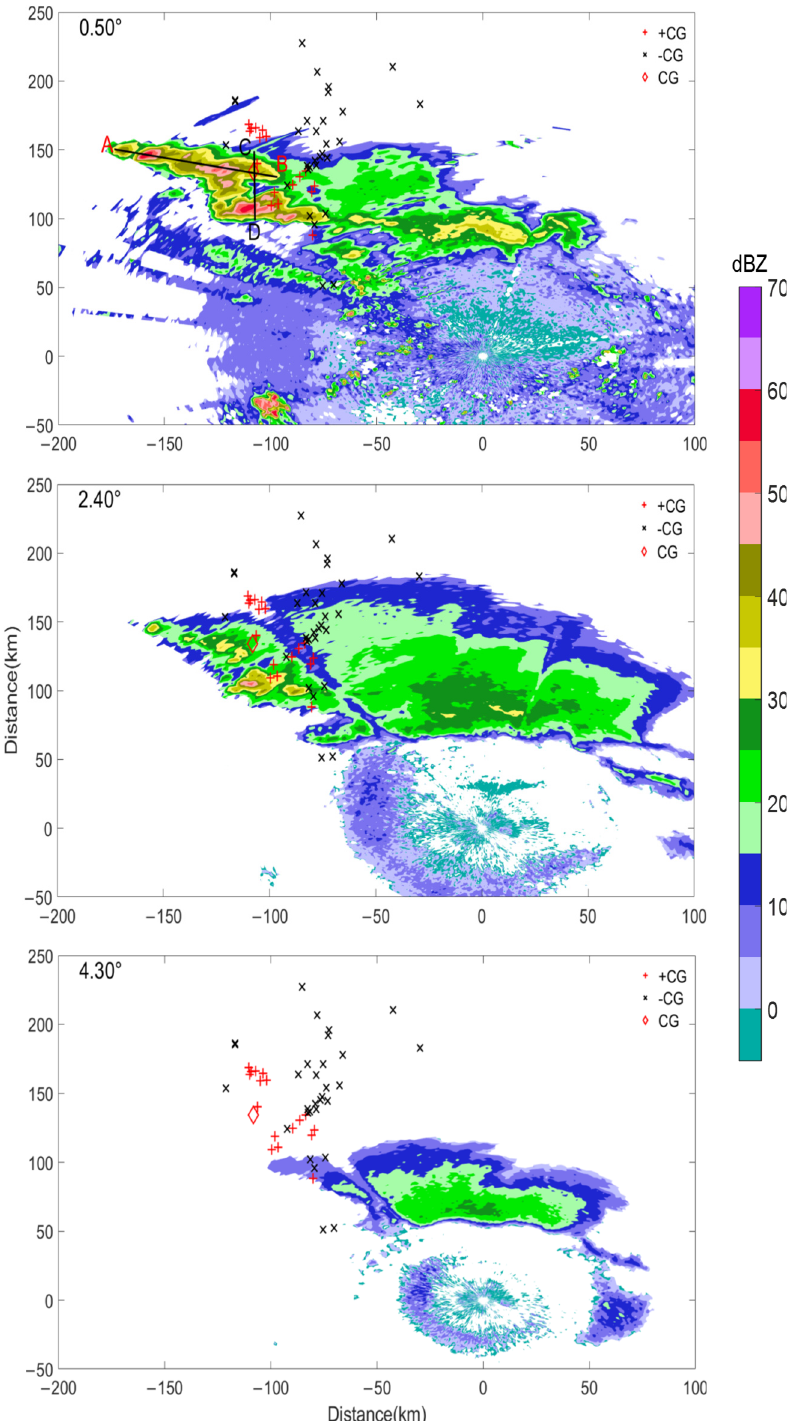
Figure 11. Overlaps of radar reflectivity at different elevation angles (shown in the figure) at 16:45 with CGs during the time period from 16:39 to 16:51. The “+” stands for +CGs and “ × ” for negative ones. The " ◇ " means that the parent flash for the sprite is marked as “ CG” in the figure. (cid:51)